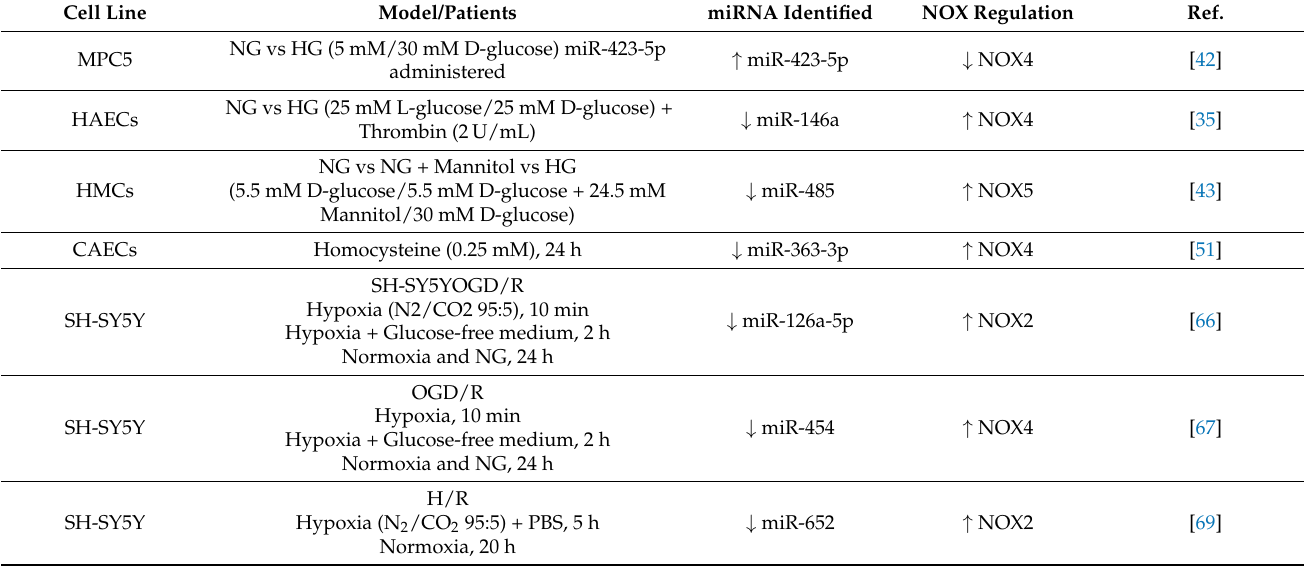
Table 2. Differential Expression of miRNAs and NOX Isoforms in vitro Legend: